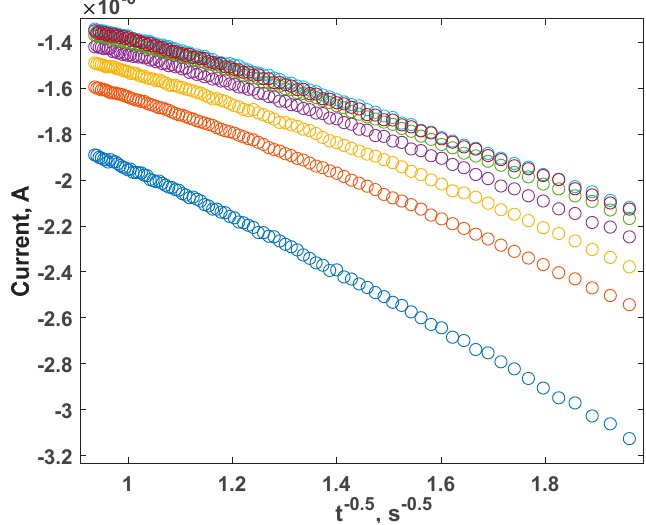
Figure 5. Plots of the current (recorded at the different deposition potentials: from − 0.2 V to − 0.26 V) as a function of the inverse square root of the time for electrodeposition of mercury on the epitaxial graphene from 0.1 M HClO 4 + 0.1 mM Hg 2+ electrolyte solution.